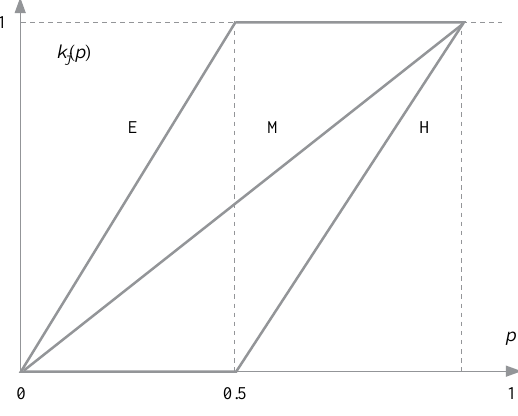
Fig. 3. Different difficulty items characteristic functions k E ( p , 0, 0.5), k M ( p , 0, 1), k H ( p , 0.5,